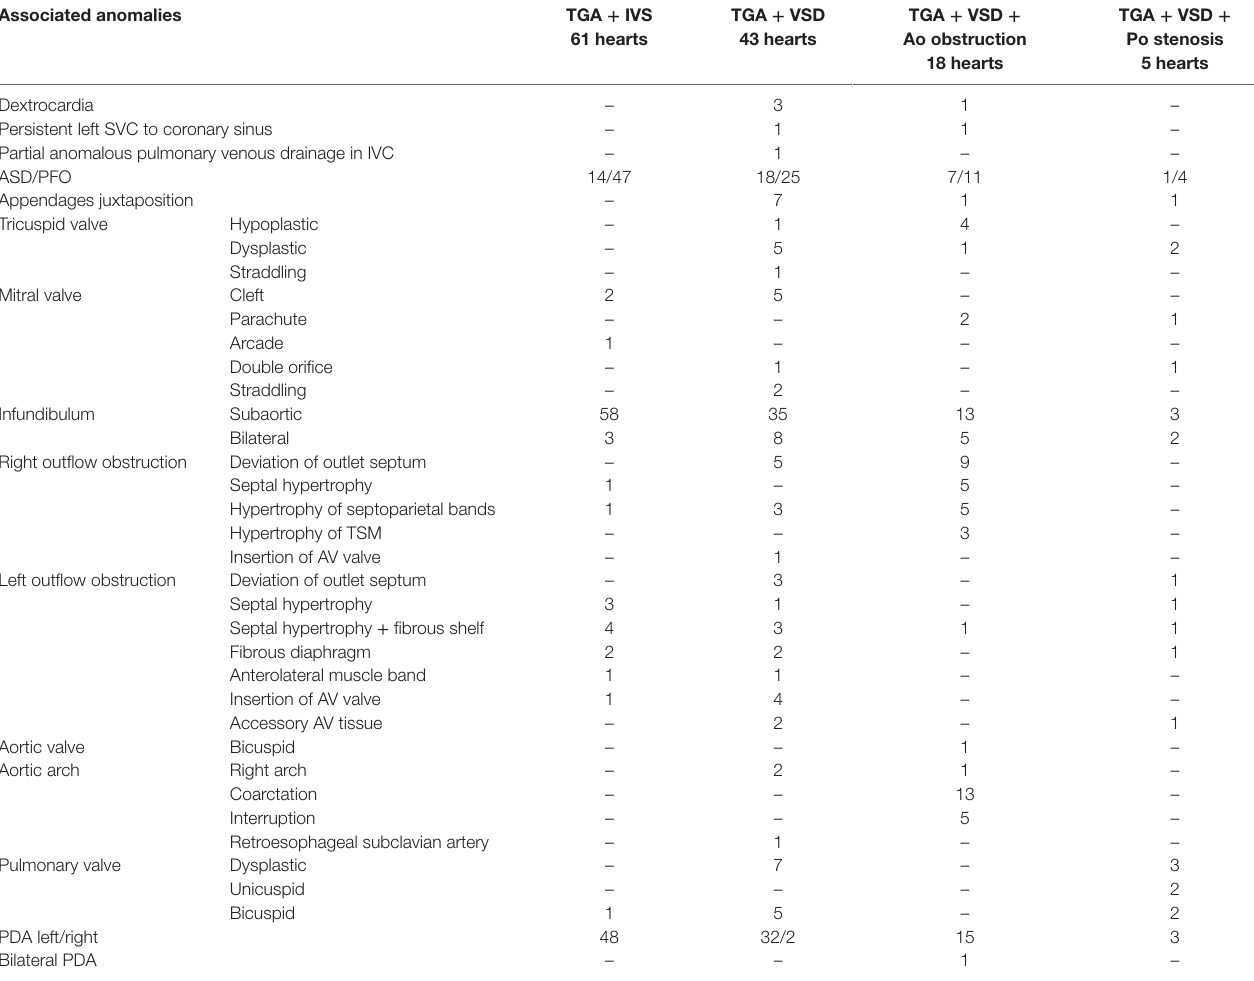
TaBle 6 | complete Tga: associated anomalies.